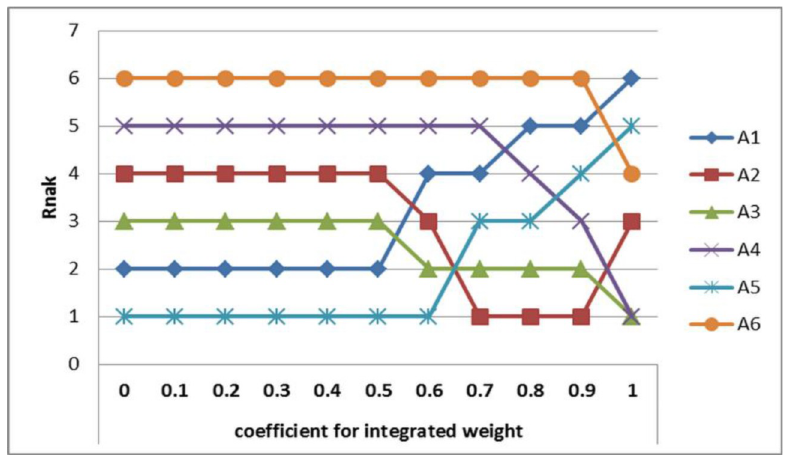
Fig 5. Sensitivity analysis of coefficient for integrated weight.